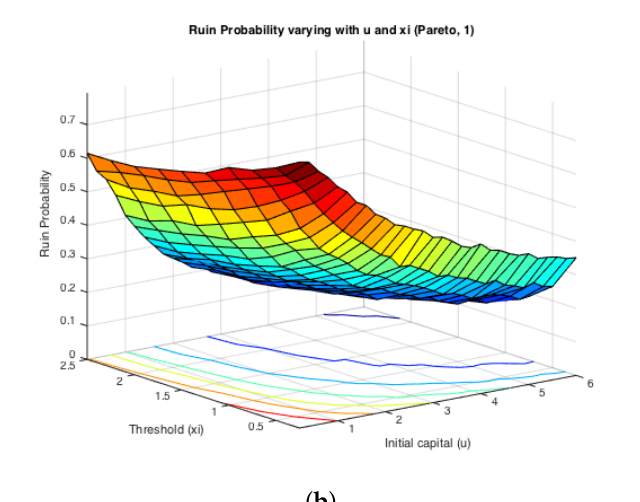
Figure 7. Examples: ruin probabilities for Pareto claims. ( a ) Ruin probabilities when λ 1 = 0.45,